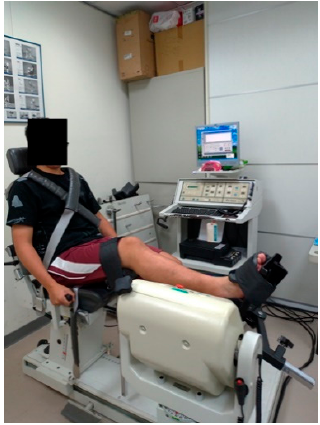
Figure 2. Biodex isokinetic dynamometer for ankle testing.